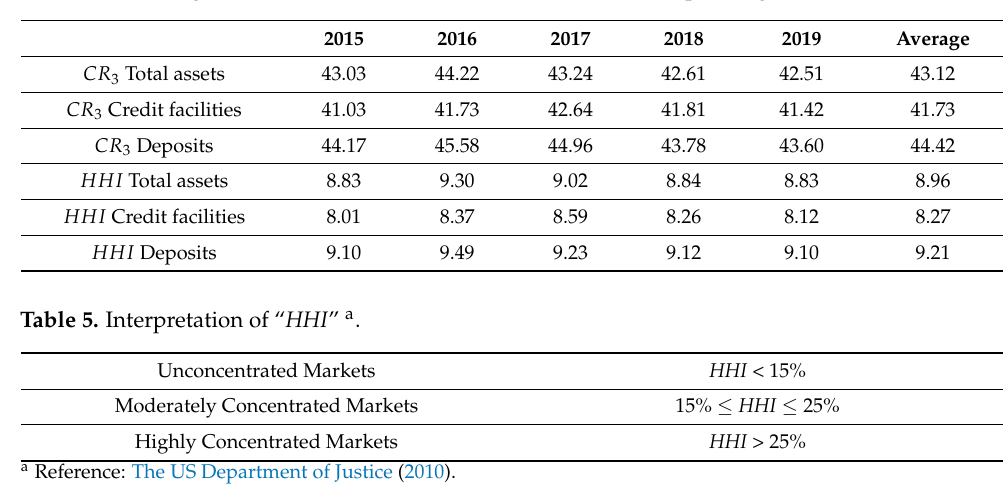
Table 4. Percentages of concentration ratio and HHI for all banks operating in Jordan.